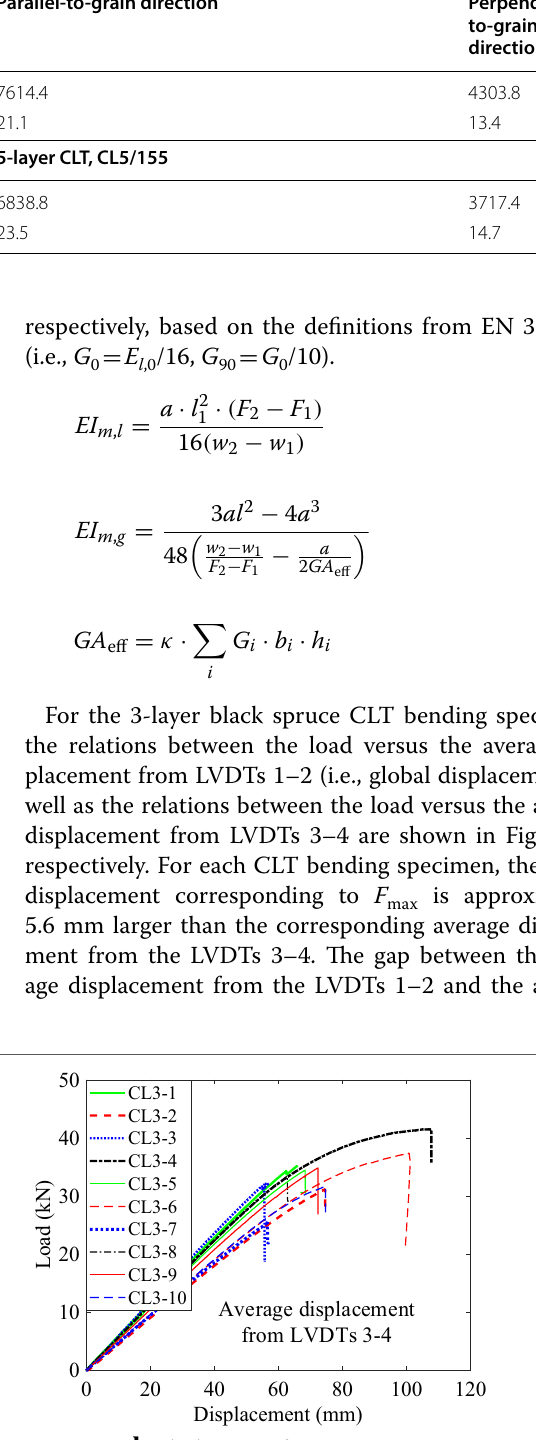
Parallel-to-grain direction Perpendicular- to-grain